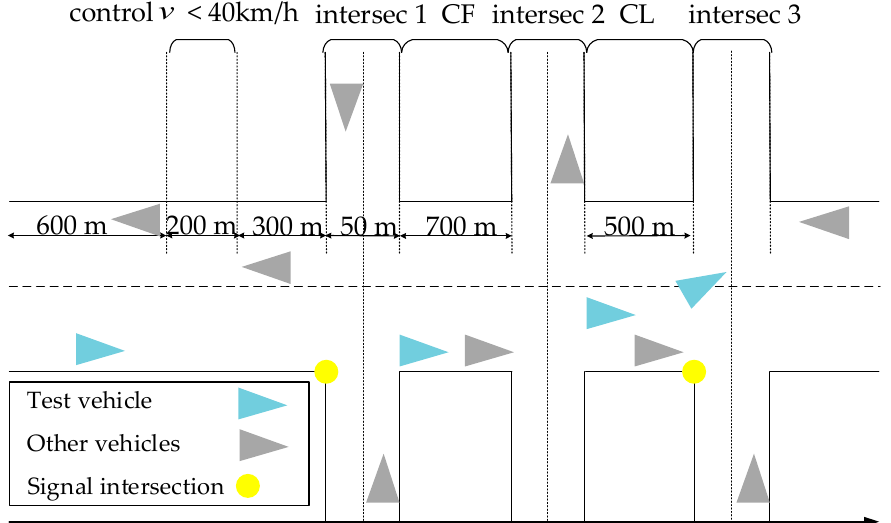
Figure 2. Schematic diagram of risk-free scenario.